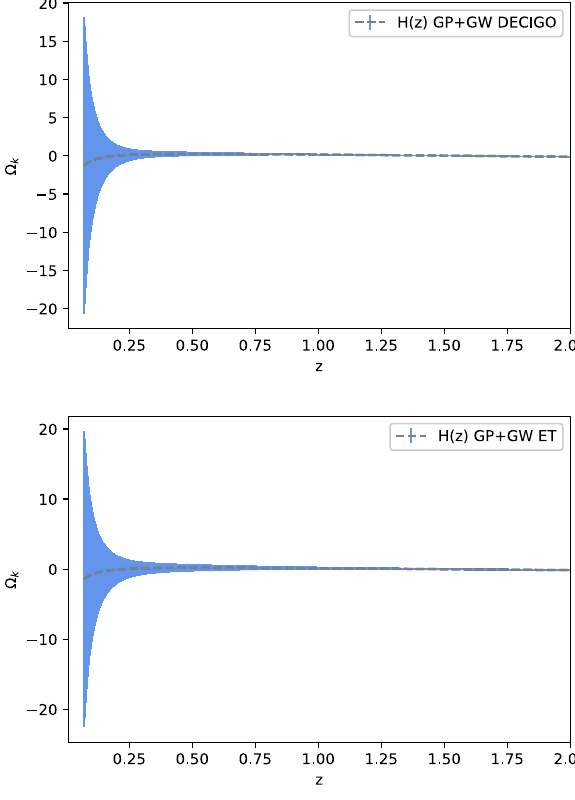
Fig. 8 Gaussian process reconstruction of Ω k obtained from the com- bined data sets of H ( z ) + DECIGO (upper) and H ( z ) + ET (lower). The blue regions are the 68% C.L. of the